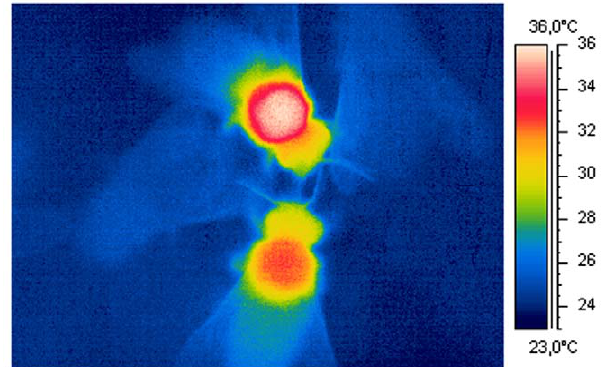
Figure 1. Close-up thermogram of honeybees. Left and right: ectothermic bees (light blue: T thorax =25.2 u C and 24.9 u C). Top and bottom: endothermic bees (white: T thorax = 35.6 u C; orange: T thorax =32.4 u C). T a =25 u C, T cell rim , 24 u C. Measurement performed in a peripheral area of an observation hive during high cold stress